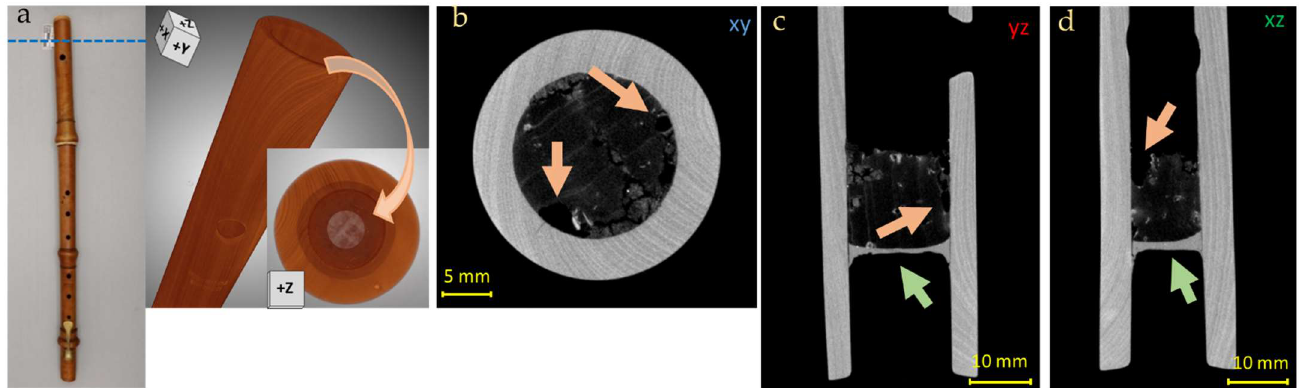
Figure 13. Original and 3D render ( a ) and CT horizontal ( b ), lateral ( c ) and vertical ( d ), slices of the Transverse Flute head, in which some voids in the cork (orange arrows) and the wax layer placed on (green arrow) are observed. Blue line in ( a ) indicates the height of the flute head in which the cork is inserted.